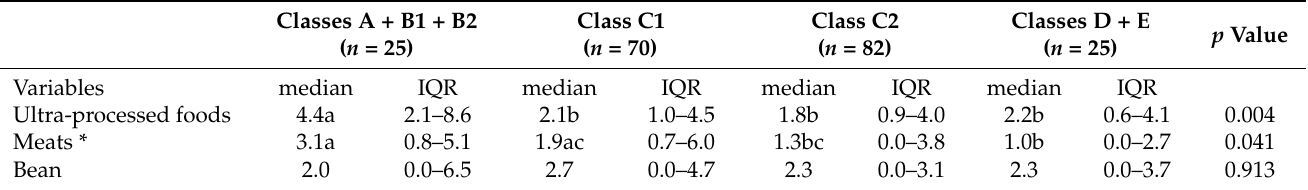
Table 4. Items of consumption that contributed most to iron intake and their distribution by socioeco- nomic